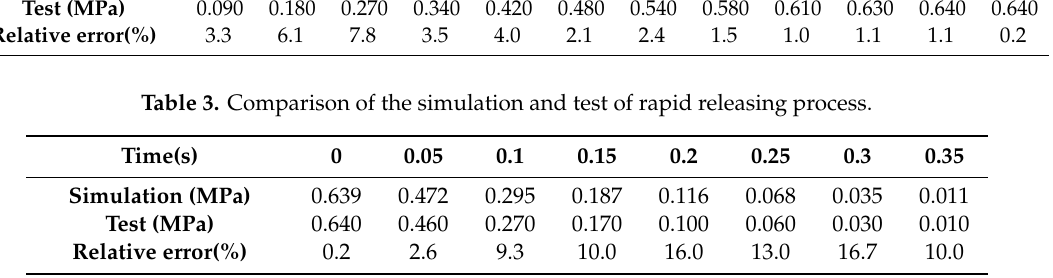
Table 3. Comparison of the simulation and test of rapid releasing process.